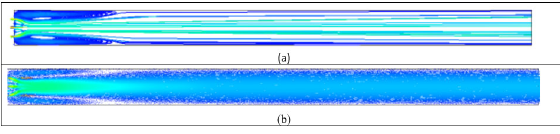
Figure 13: The effect of channel length on the flow for three jets in Re=35 a) streamlines, b) velocity of